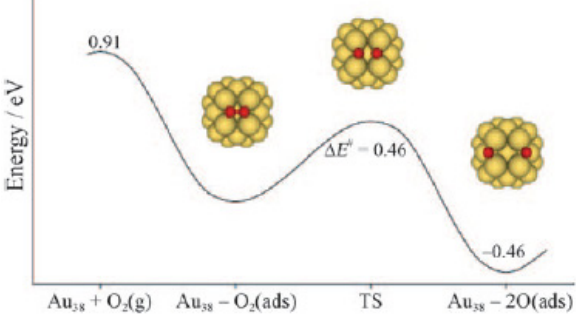
Figure 9. Atomic structure for the most favorable energy profile for O cluster [75]. Au 38